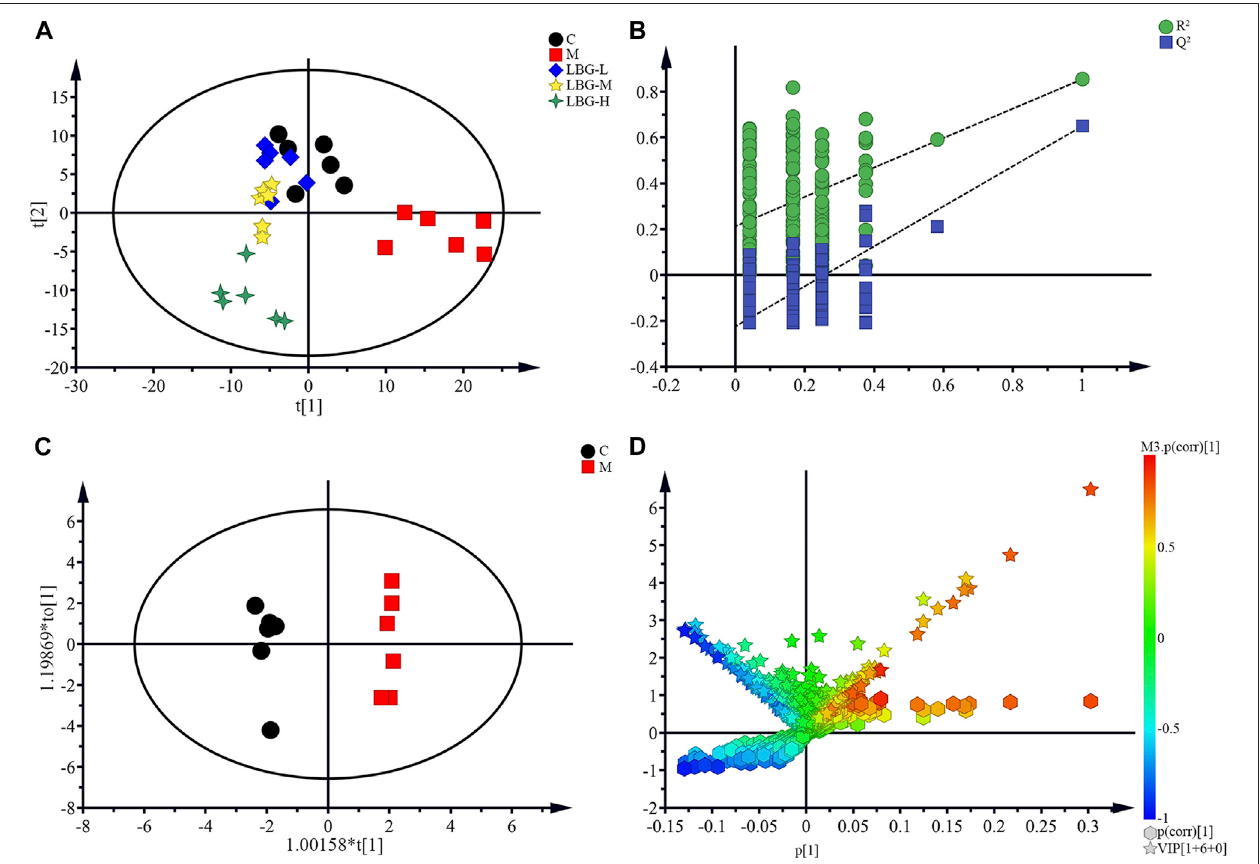
FIGURE 3 | Pattern recognition of Simca-P 14.1. (A) Results of multiple pattern recognition of spleen metabolites in C, M, LBG groups. PLS-DA score plot ( n (cid:2) 6). (B) Results ofpermutationtests. R 2 (cid:2) 0.854, Q 2 (cid:2) 0.649. (C) OPLS score plot ( n (cid:2) 6, R 2 Y (cid:2) 0.947, R 2 X (cid:2) 0.431, Q 2 (cid:2) 0.659) ofC group and M group. (D) OPLS (S + V)- plot of C group and M group. Each point in the (S + V)-plot represents an ion. Ions far away from the origin were potential biomarkers.